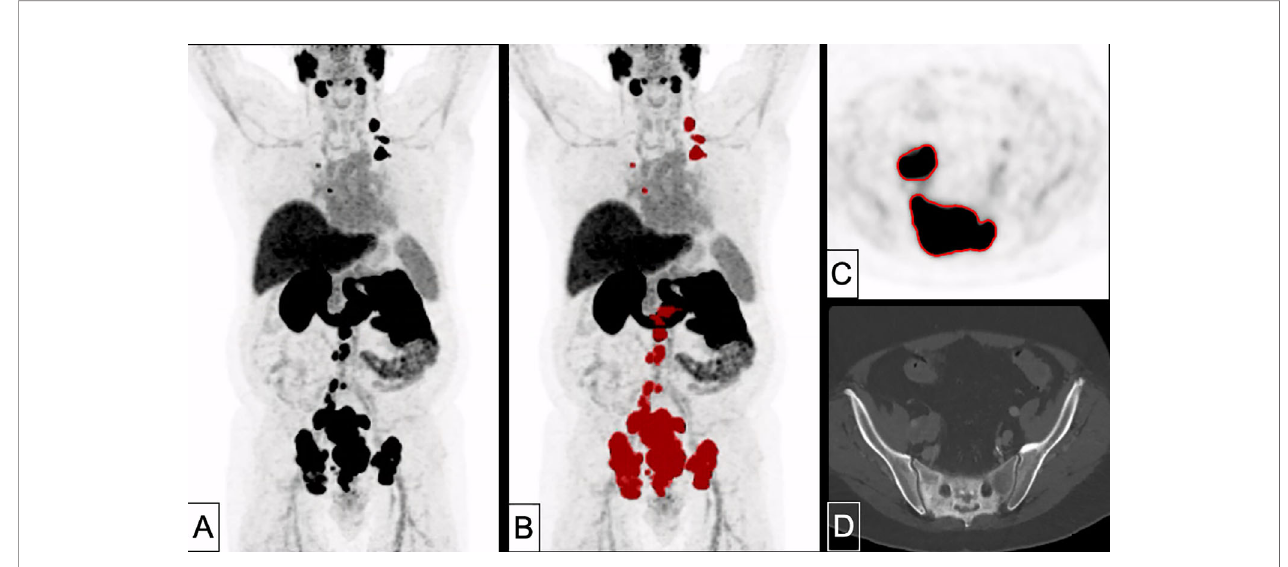
FIGURE 5 | A 70 years-old patient with primary prostate cancer remnant with bone, pleura and lymph node metastases (PSA 78.0 ng/ml, Gleason 10). Tumor delineation using a cut-off of SUV 4.0 revealed a WTV of 586 ml. (A) : MIP; (B) MIP + WTV (red color); (C) delineation of bone and lymph node metastasis on PET; (D) CT correlate (bone